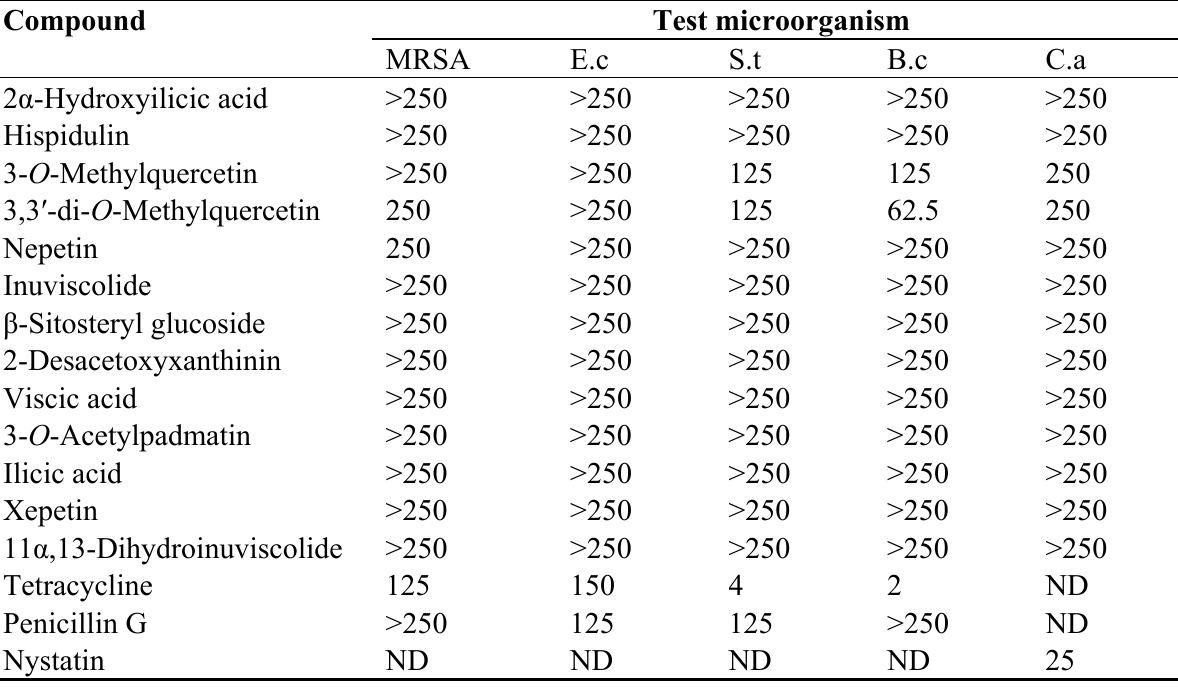
Table 2. Minimum inhibitory concentration (MIC) in µg/mL of Inula viscosa compounds. Microbial species: Methicillin resistant Staphylococcus aureus (MRSA); Bacillus cereus (B.c); Escherichia coli (E.c); Salmonella typhimurium (S.t); C andida albicans (C.a). ND: not determined. Pure tetracycline, penicillin G, and nystatin were included for comparative